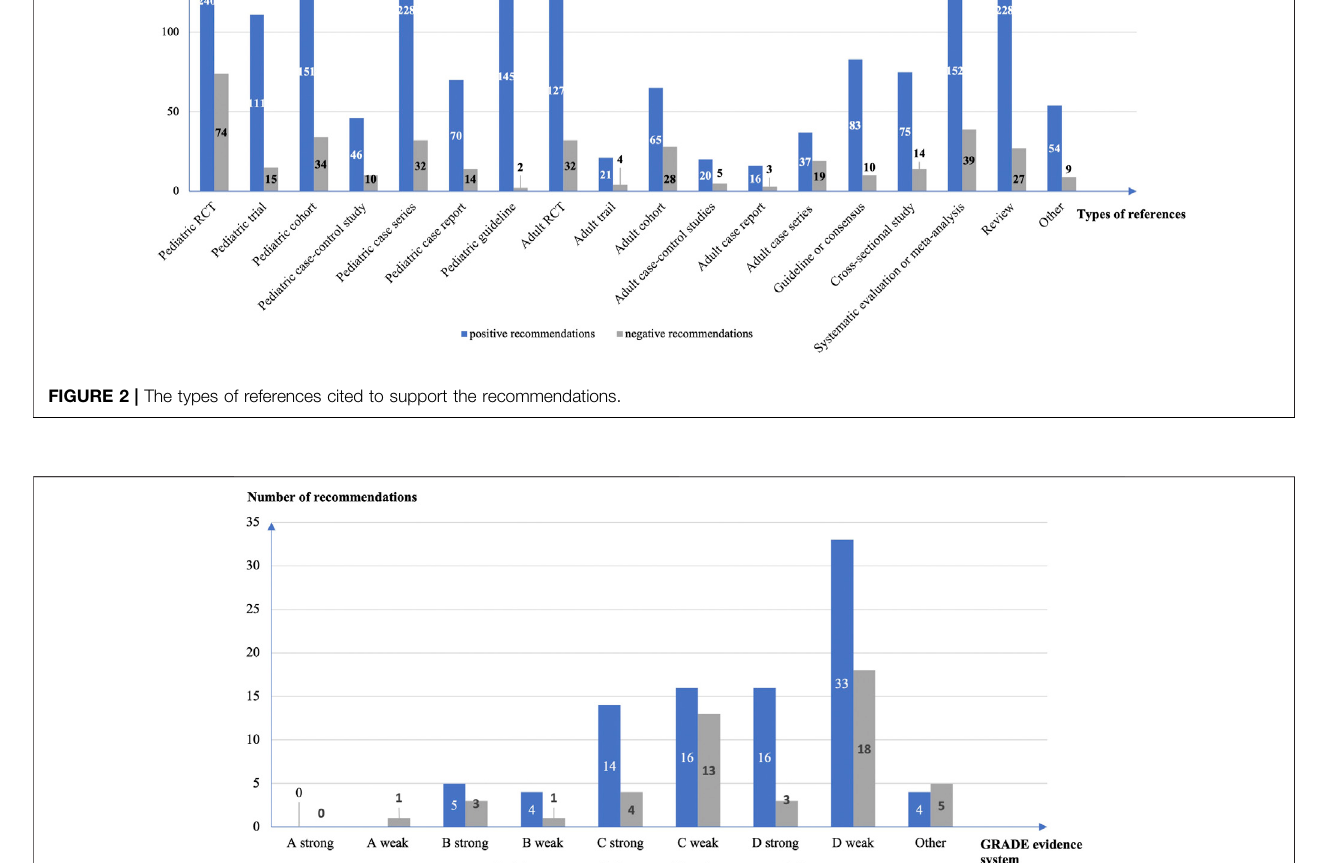
FIGURE 3 | Strength of the off-label drug use recommendations and quality of the supporting evidence according to the GRADE grading system.